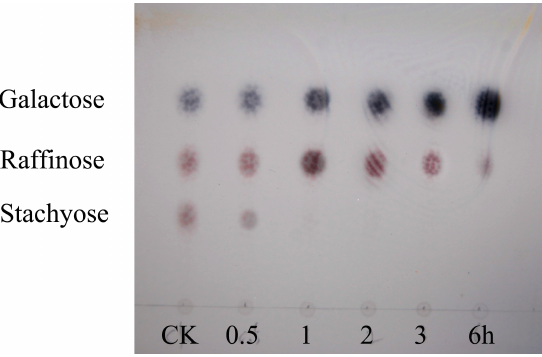
Figure 4. Analysis of products of oligosaccharide hydrolysis by TEG. CK stands for control group (0 min), which indicates oligosaccharides (stachyose, raffinose, galactose) without α -galactosidase treatment.